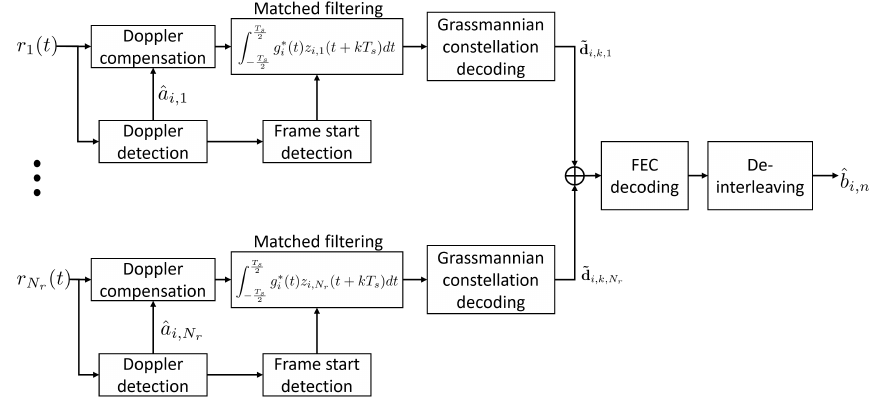
Figure 3. Receiver